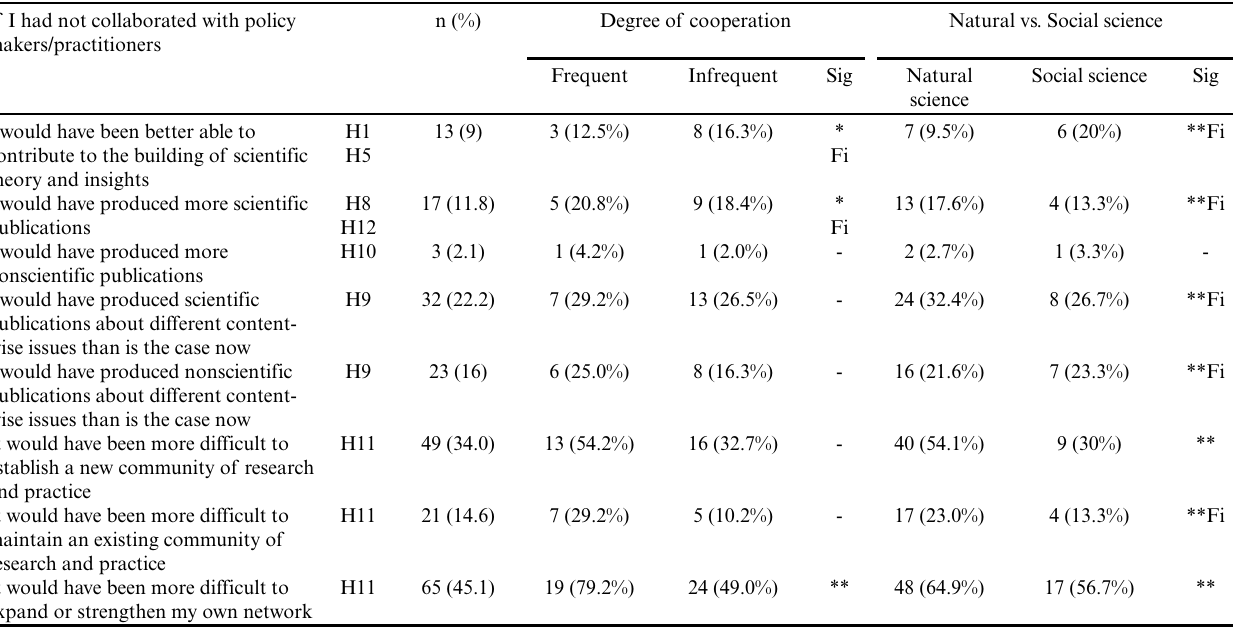
Table 7 . Reported substantive output of the joint knowledge production (JKP)